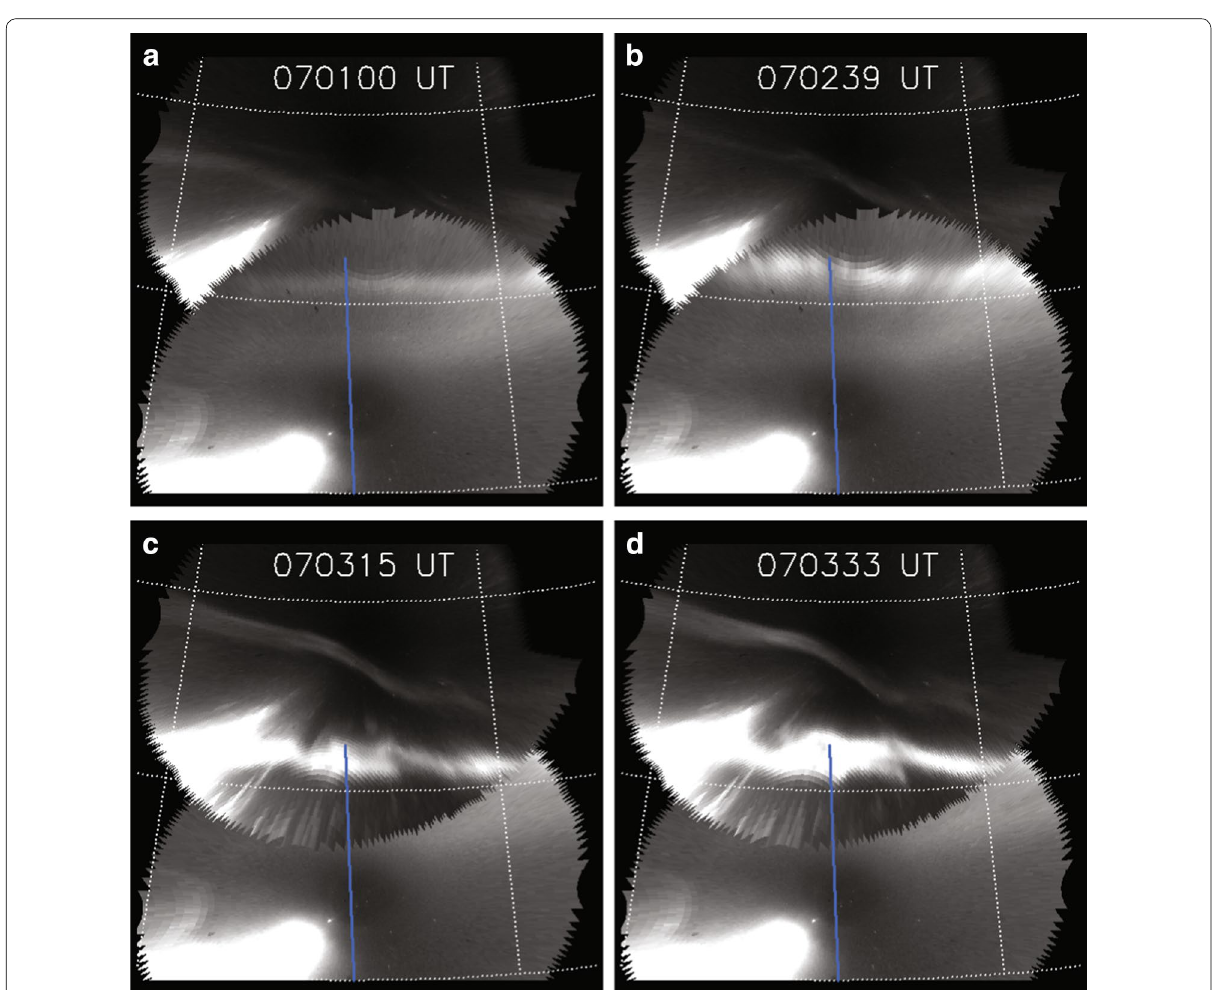
Fig. 6 THEMIS ASI images showing substorm onset on 2016-12-09. A few selected auroral images from ATHA ASI (lower-latitude one) and FSMI ASI (higher-latitude one) showing the substorm onset on 2016-12-09. An emission altitude of 100 km is used here based upon a triangulation technique of the arc in the overlapping area of two ASIs. A blue line denotes the FESO scan meridian. The images are indexed to facilitate referene in the